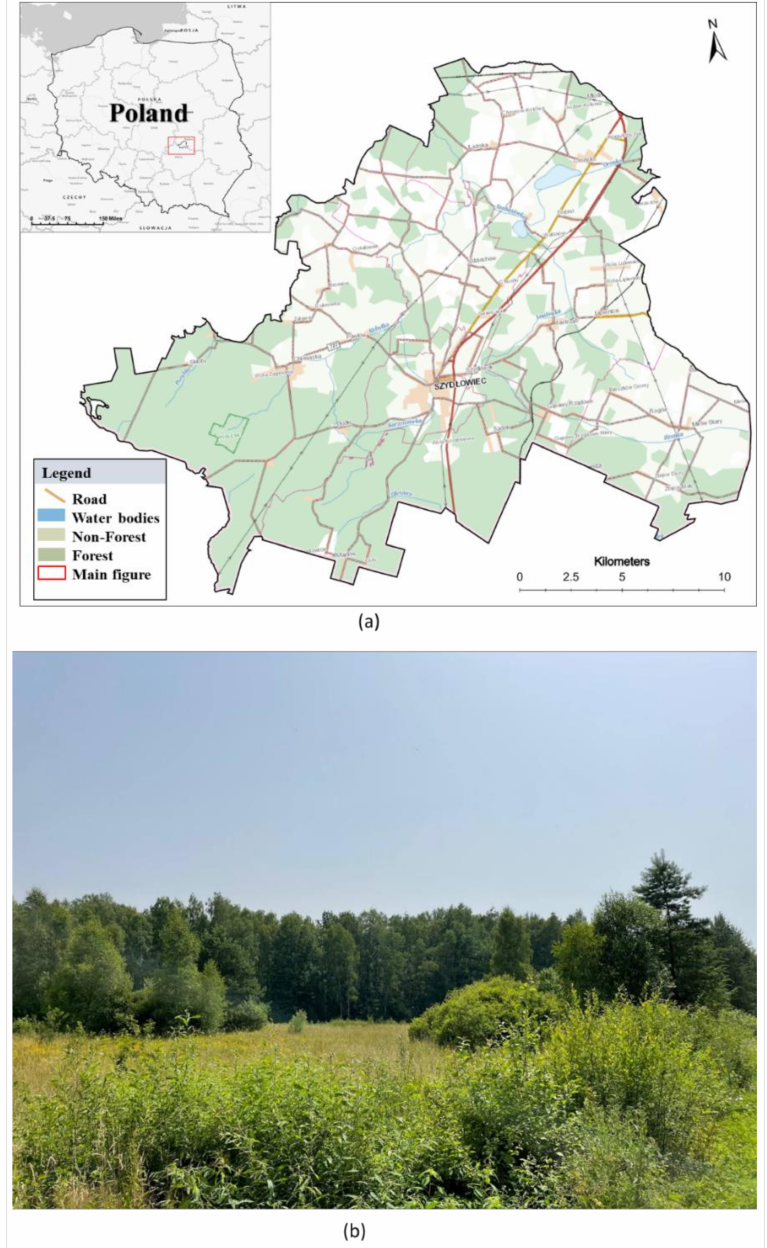
Figure 1. ( a ) The location of Szydłowiec county. Background national geographic map; ( b ) A photo of abandoned fields taken in July 2021, M.